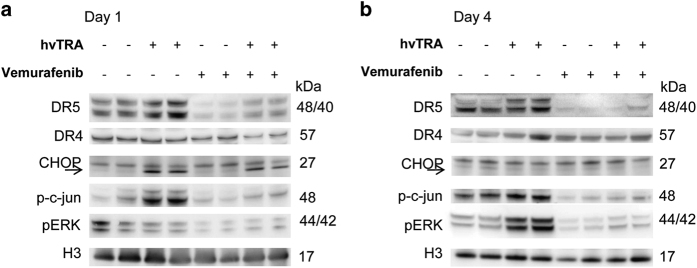
Evaluation of apoptotic proteins in response to hvTRA, vemurafenib or the combination measured by western immunoblot. Western immunoblot detection of DR5, DR4, CHOP, p-c-jun and pERK to investigate the Melmet 5 xenografts response to hvTRA and vemurafenib after (a) 1 day or (b) 4 days of treatment with vemurafenib (50 mg/kg twice a day), hvTRA (3 mg/kg) or the combination. CHOP is indicated by an arrow. H3 was used as loading control. Tumors were harvested 2 h after the last treatment. Each lane in a and b represents one individual tumor.